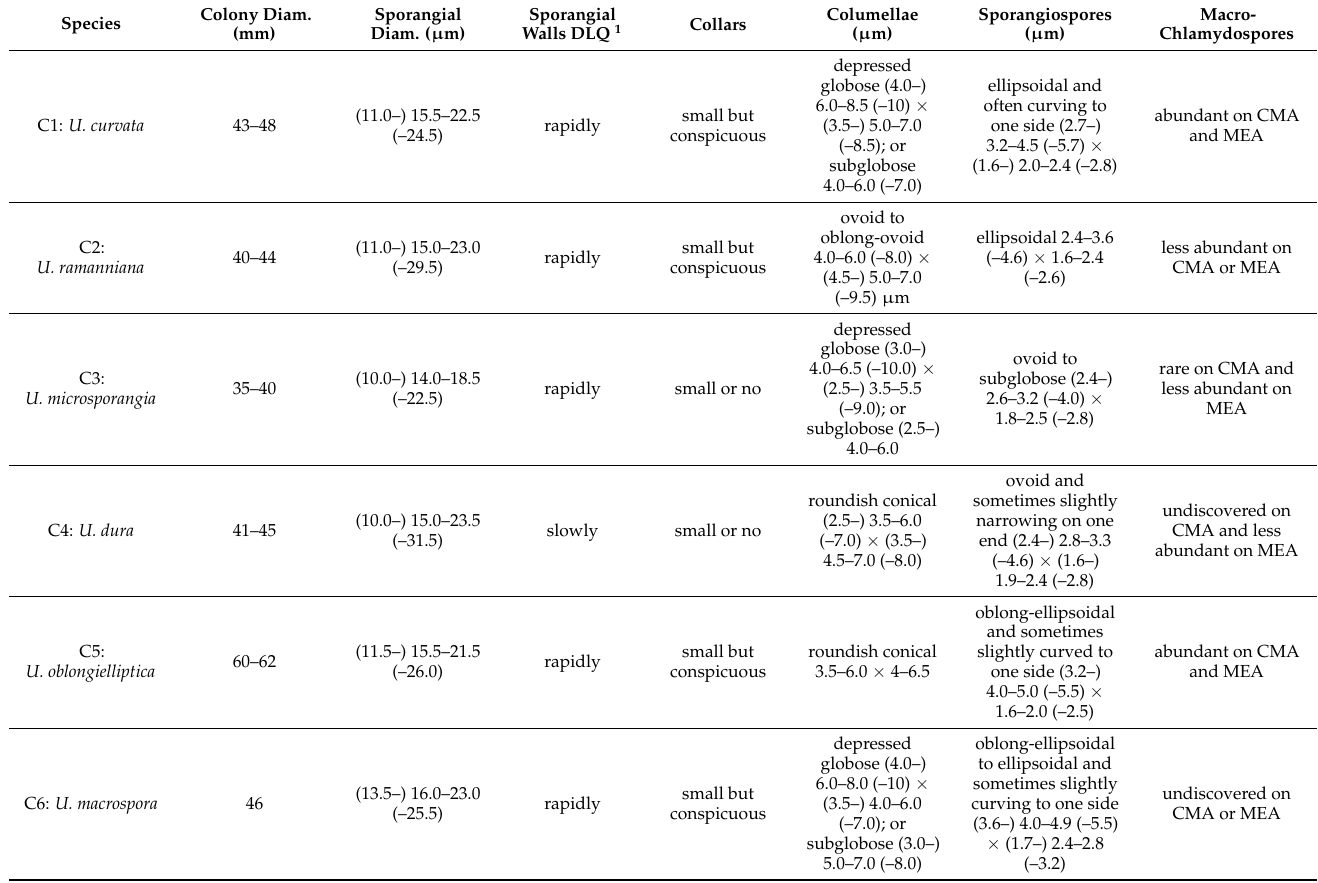
Table 1. The mainly morphological comparison among Umbelopsis ramanniana